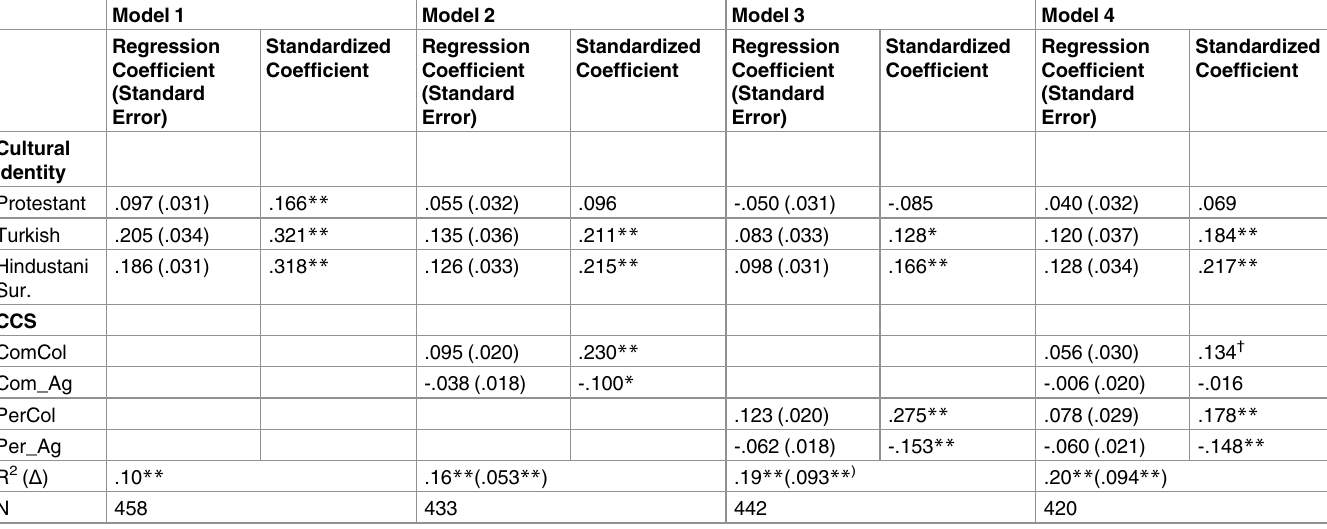
Table 8. Regression analysis: Behavioral intentions predicted by cultural identity and